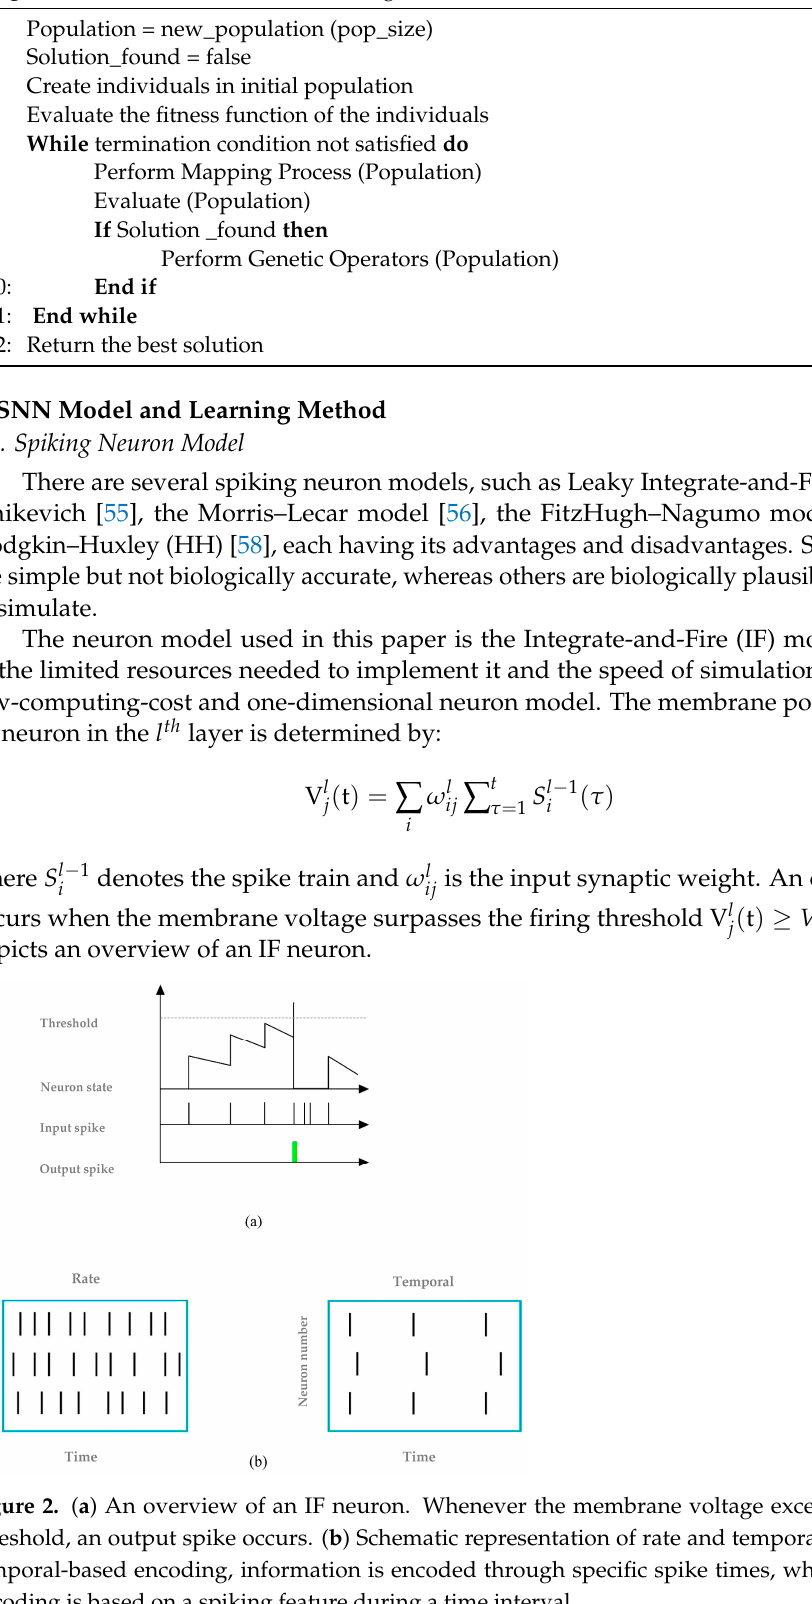
Algorithm 7. Grammatical Evolution Algorithm